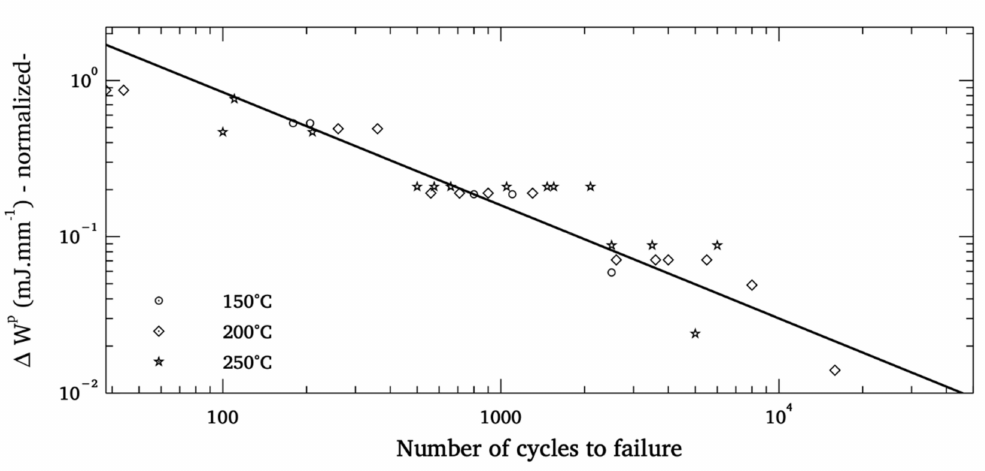
Figure 11. Dispersion observed on aluminum alloys Low-Cycle Fatigue